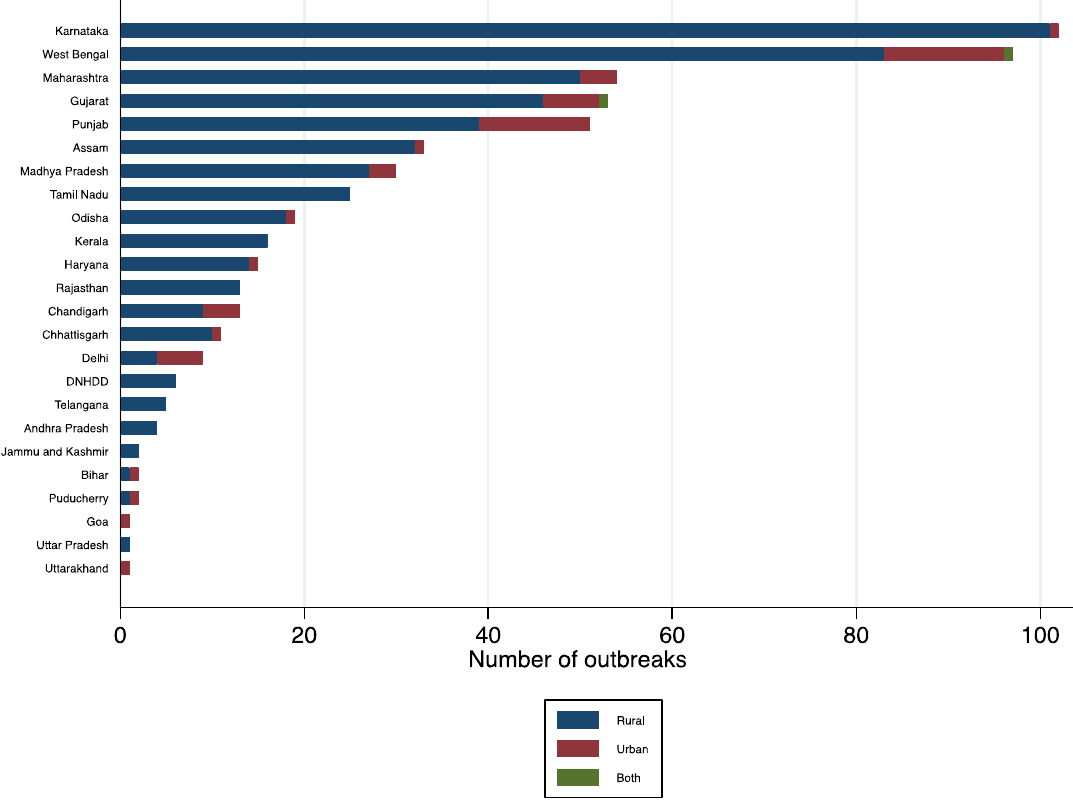
Figure 7. Cholera outbreaks ( n = 565) by type of setting (rural vs. urban), India, 2011–2020. DNHDD = Dadra and Nagar Haveli and Daman and Diu.